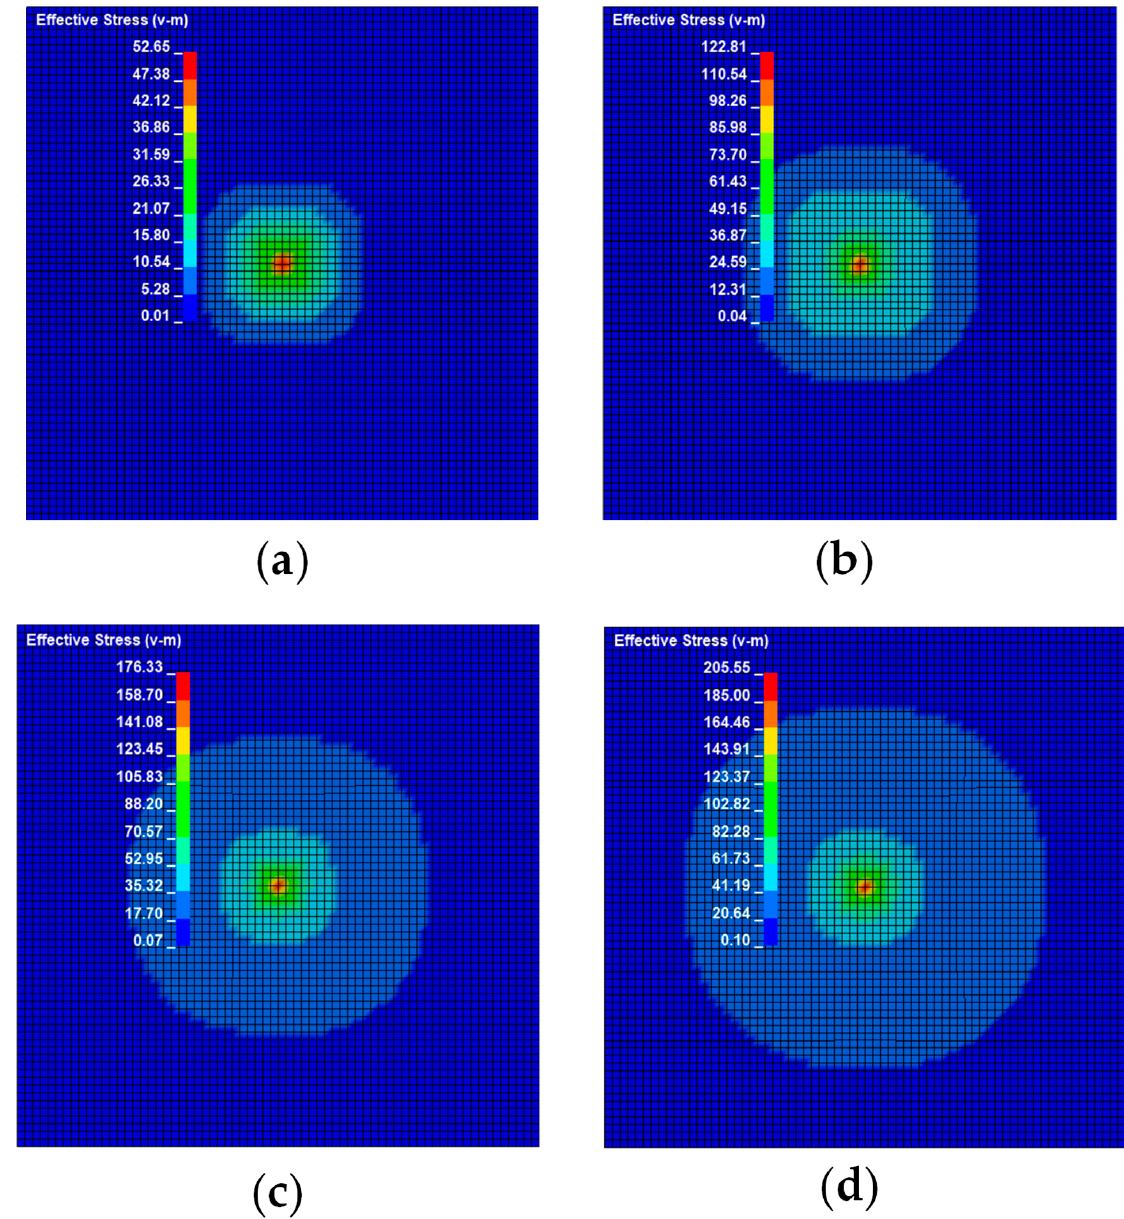
Figure 6. Stress cloud diagram of impact response at different velocities at position 1: ( a ) shock response stress cloud diagram at an impact speed of 1 m/s; ( b ) shock response stress cloud diagram at an impact speed of 1.5 m/s; ( c ) shock response stress cloud diagram at an impact speed of 2 m/s; ( d ) shock response stress cloud diagram at an impact speed of 2.5 m/s.